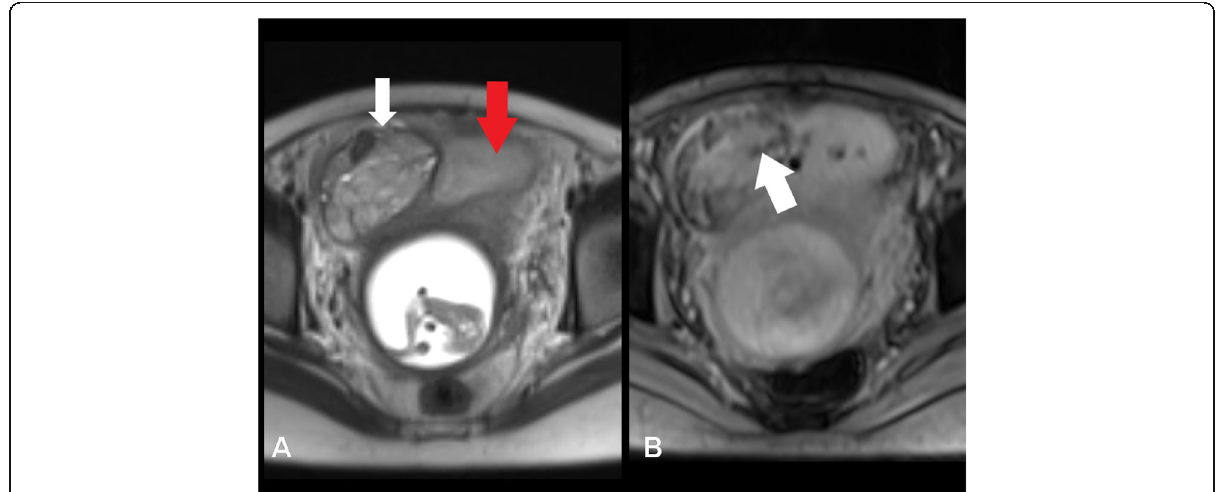
Fig. 6 Pregnant female with right iliac fossa pain. a Axial T2 W image shows enlarged right ovary with peripherally placed follicles(white arrow) and adjacent fluid (red arrows). b Axial gradient (GRE) image shows hemorrhage within suggesting ovarian torsion (white